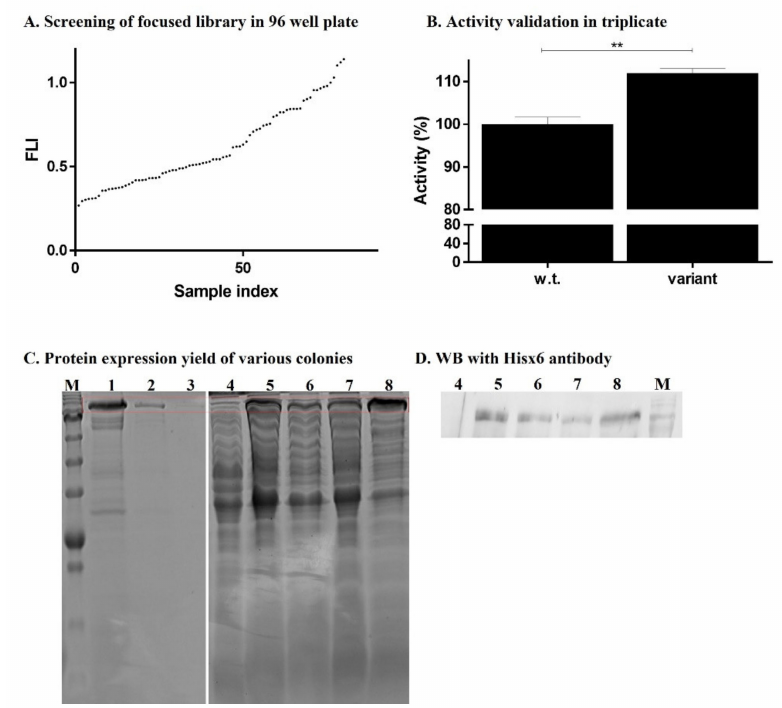
Figure 4. Screening of a genetic library of Col G. ( A ) The relative intensity following an enzymatic reaction of selected colonies. ( B ) The colony showing high activity was replated and colonies were grown and tested in triplicate, and activity is shown relative to the wild-type Col G. ** Calculated p -value was 0.0016. ( C ) SDS-PAGE gel showing ColG content in colonies cultured in a 2 mL deep-well plate for screening of ColG activity. M-Marker. Lanes 1–3–10 µ g, 1 µ g, and 0.1 µ g of purified ColG, respectively. Lane 4-noninduced cells. Lanes 5–8-colonies expressing wild-type, phe782ser, and two randomly selected colonies, respectively. ( D ) Western blot analysis with Hisx6 antibody showing the same bacterial lysate of Lanes 4–8 as in ( C